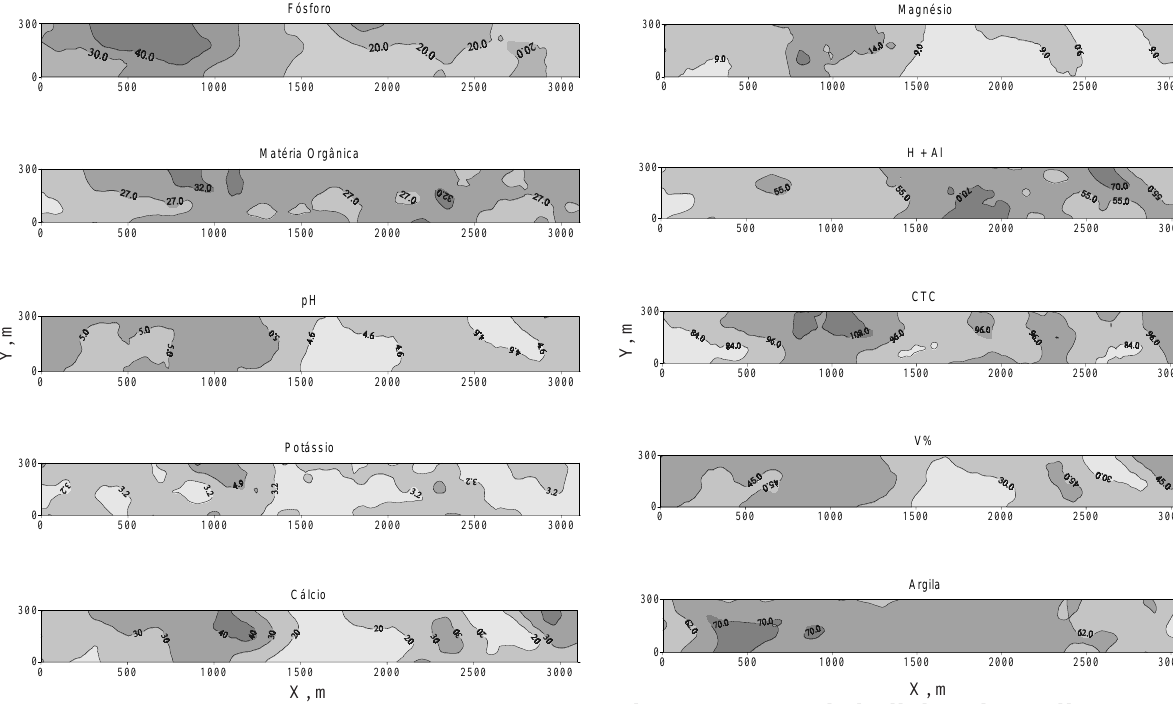
Figura 2. Mapas de isolinhas dos atributos Mg 2+ , H + Al, CTC, V % e teor de argila, na profundi- dade de 0,00–0,20 m.